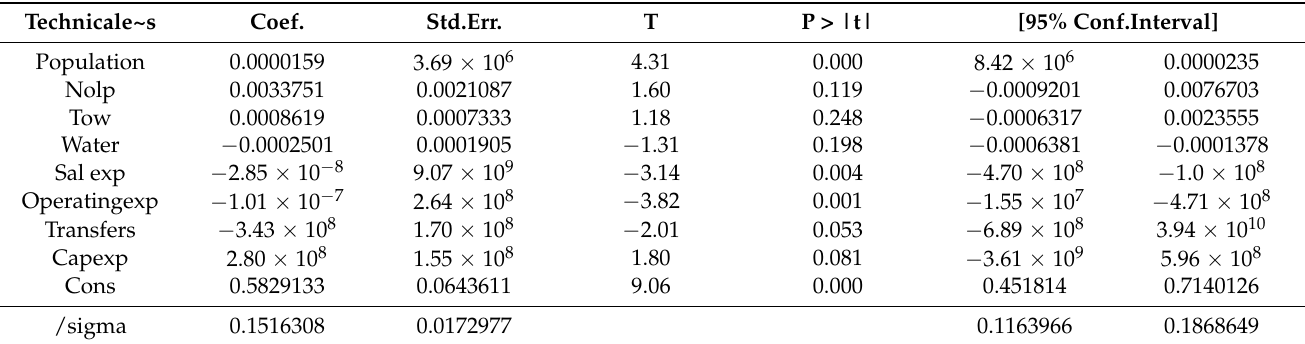
Table 14. Tobit Results between